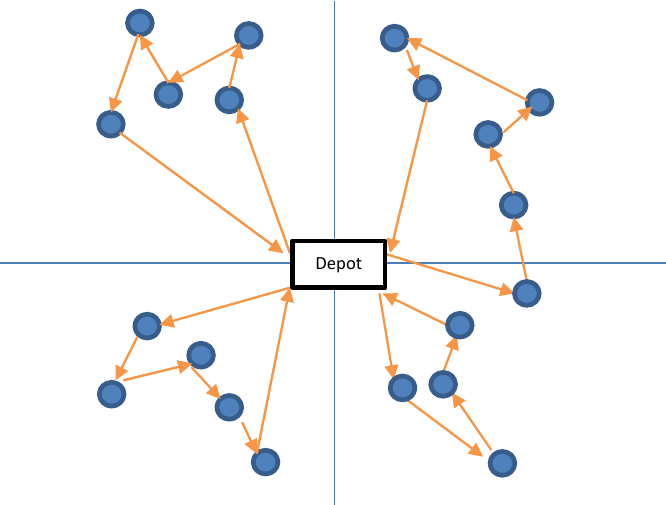
Fig. 5. GAP model for each cluster